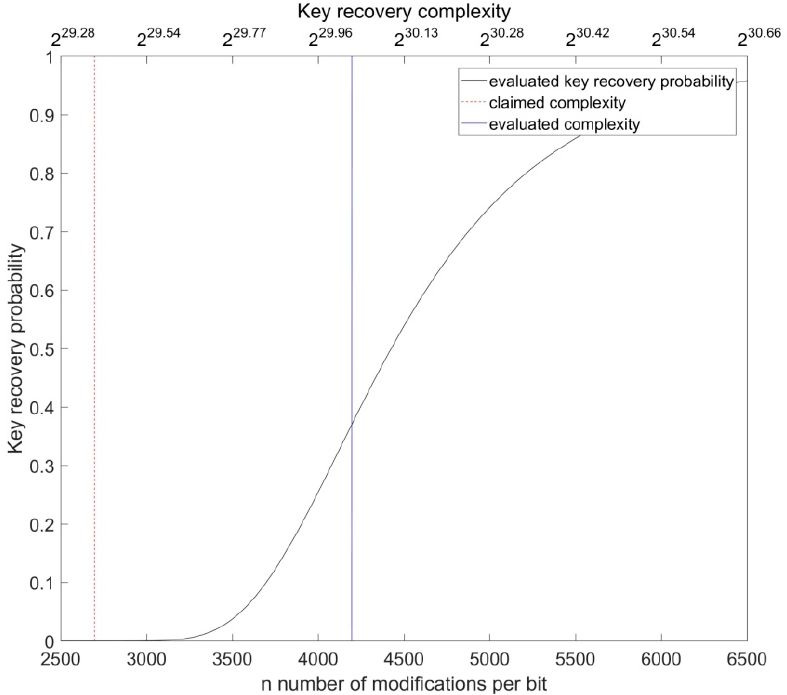
Figure 14. The increase rate of the key recovery probability of the OOV algorithm for the Random-HB# protocol depending on the number of modifications n and total key recovery complexity respectively. In order to achieve the attack precision claimed in [13], the number of per-bit modifications, i.e., the complexity of the attack, should be increased by 55%.